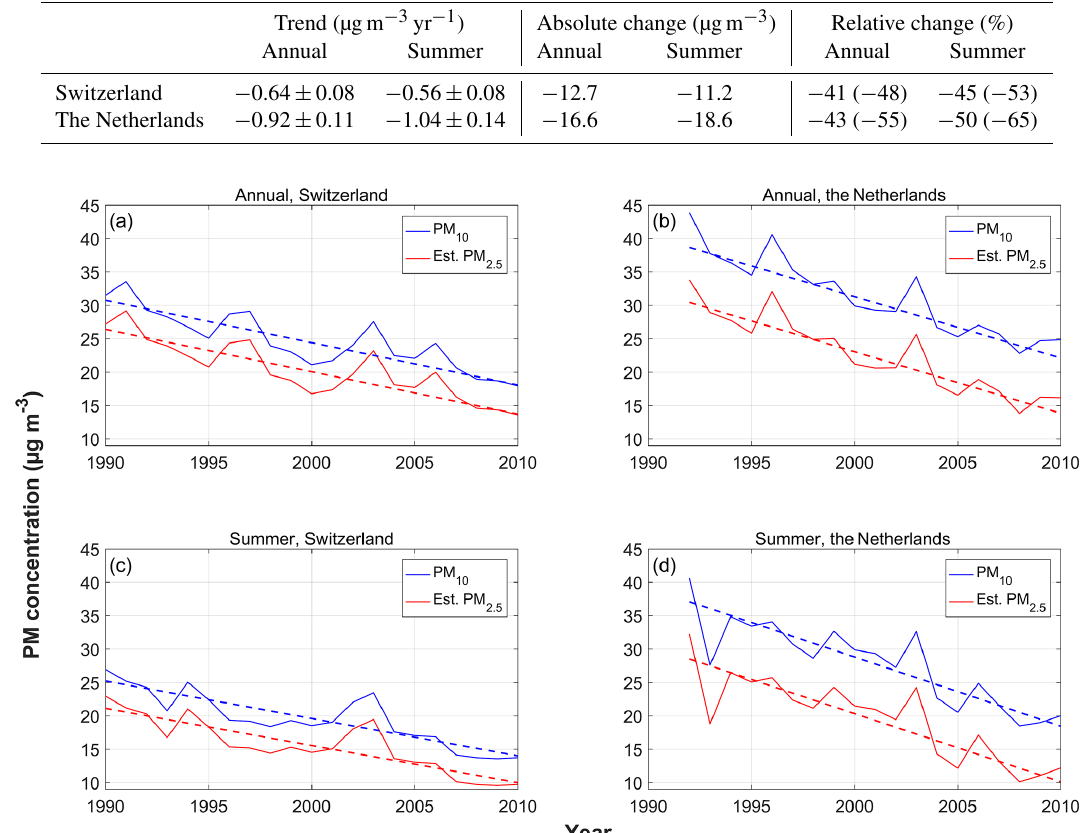
Figure 1. Annual (a, b) and summer (c, d) concentrations of PM 10 (blue) and PM 2 . 5 (red) measured at three stations in Switzerland (a, c) and at three stations in the Netherlands (b, d) for the period 1990–2010 and 1992–2010, respectively. Dashed lines show the linear regression fit. PM 2 . 5 concentrations were estimated as described in Sect.